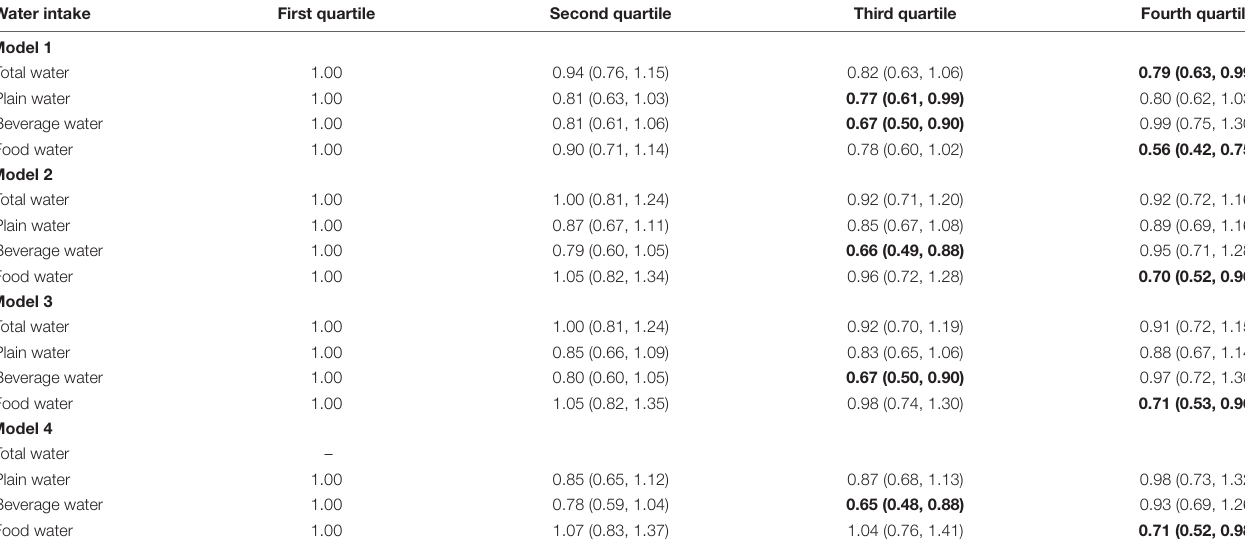
TABLE 3 | Associations of total water, plain water, beverage water, and food water intake with malignant neoplasms/cancer mortality risk in the NHANESs 1999–2014